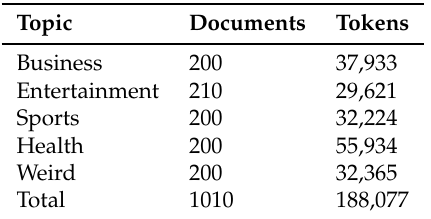
Table 3. Detail of Dataset with